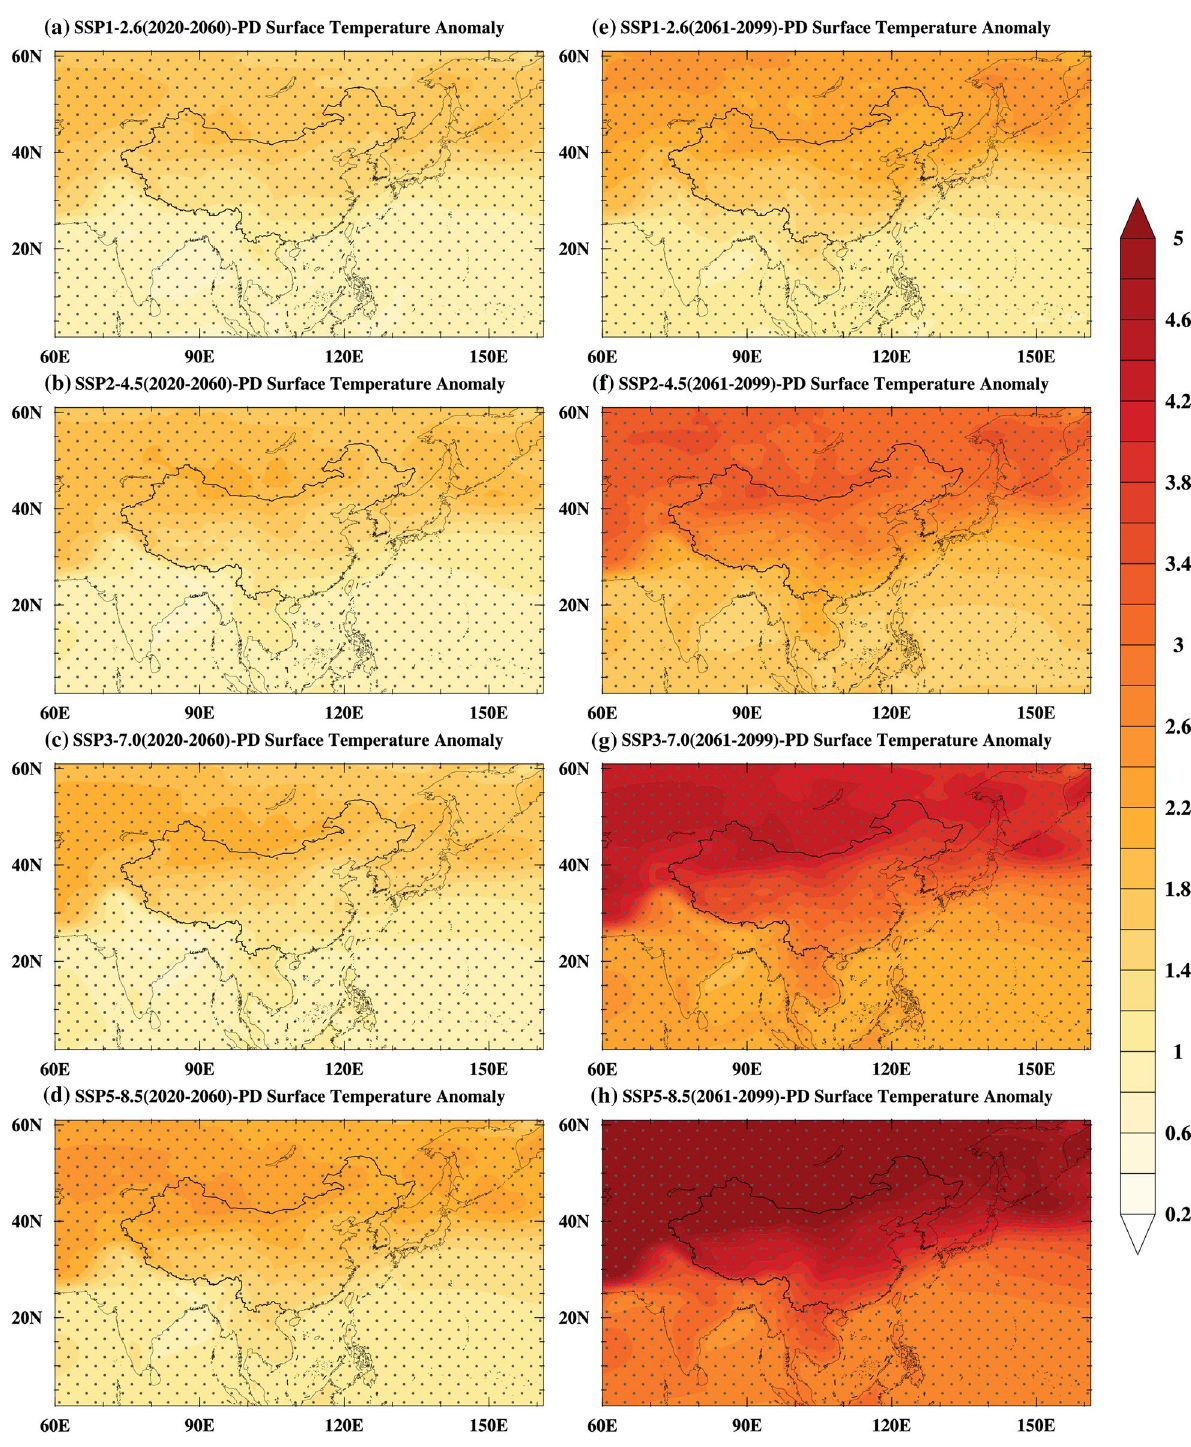
Figure 5. Summer surface air temperature anomalies (unit: o C, shading) for 2020–2060 (near-term, a – d ) and 2061–2099 (late-term, e – h ) under the SSP1-2.6 ( a , e ), SSP2-4.5 ( b , f ), SSP3-7.0 ( c , g ), SSP5-8.5 ( d , h ) relative to the present day. The grey dots indicate a 5% of significance level. Maps were generated using the NCAR Command Language (The NCAR Command Language (Version 6.6.2) [Software]. (2019). Boulder, Colorado: UCAR/ NCAR/CISL/TDD. https:// www. ncl. ucar. edu/ Downl